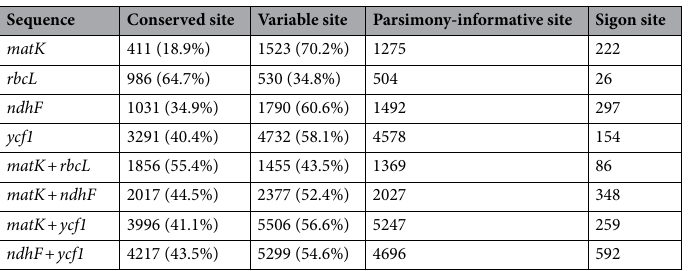
Table 3. The analysis of variation of candidate barcode sequences in Orchidaceae plants.